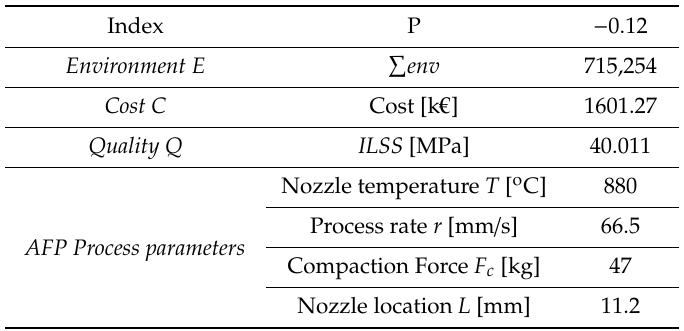
Table 12. Optimized AFP process parameters and corresponding Quality, Cost and Environmental factors.